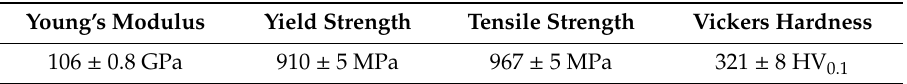
Table 1. Materials properties of Ti6Al4V ELI (measured